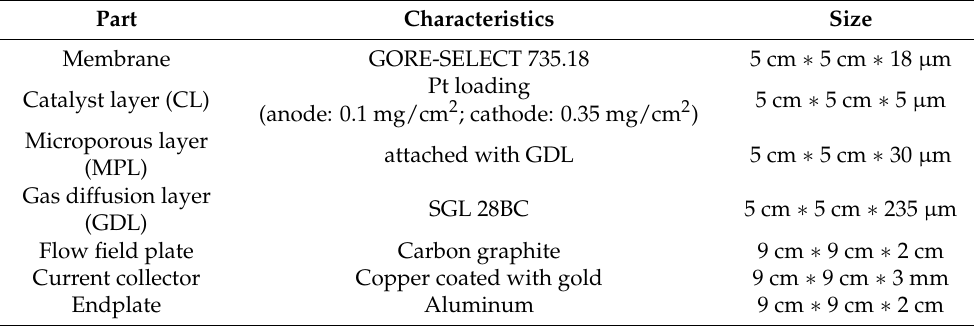
Table 1. Specifications of components of the PEMFC.